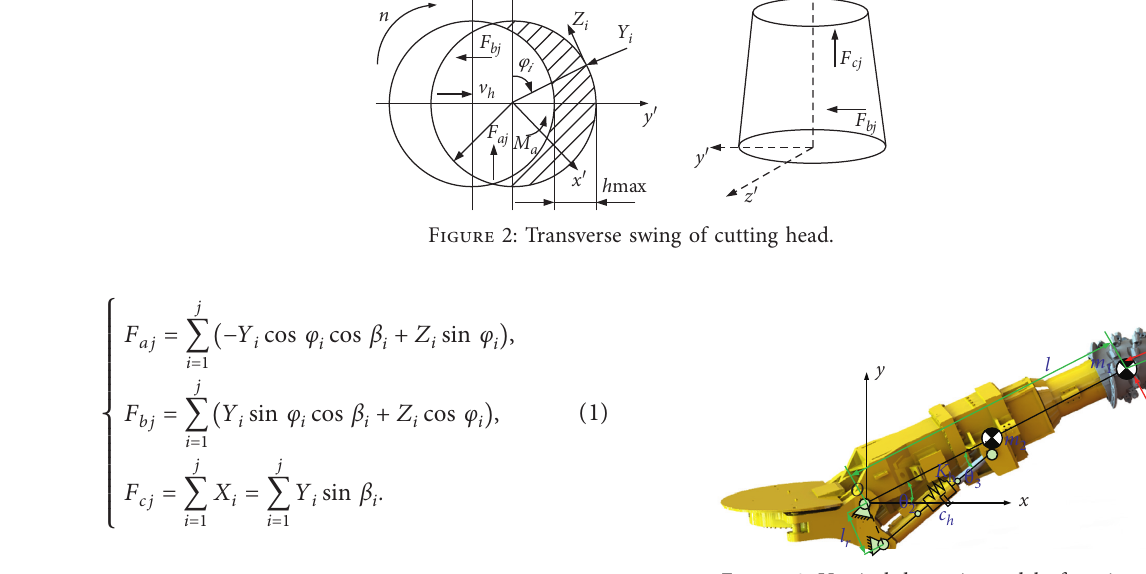
Figure 3: Vertical dynamic model of cutting